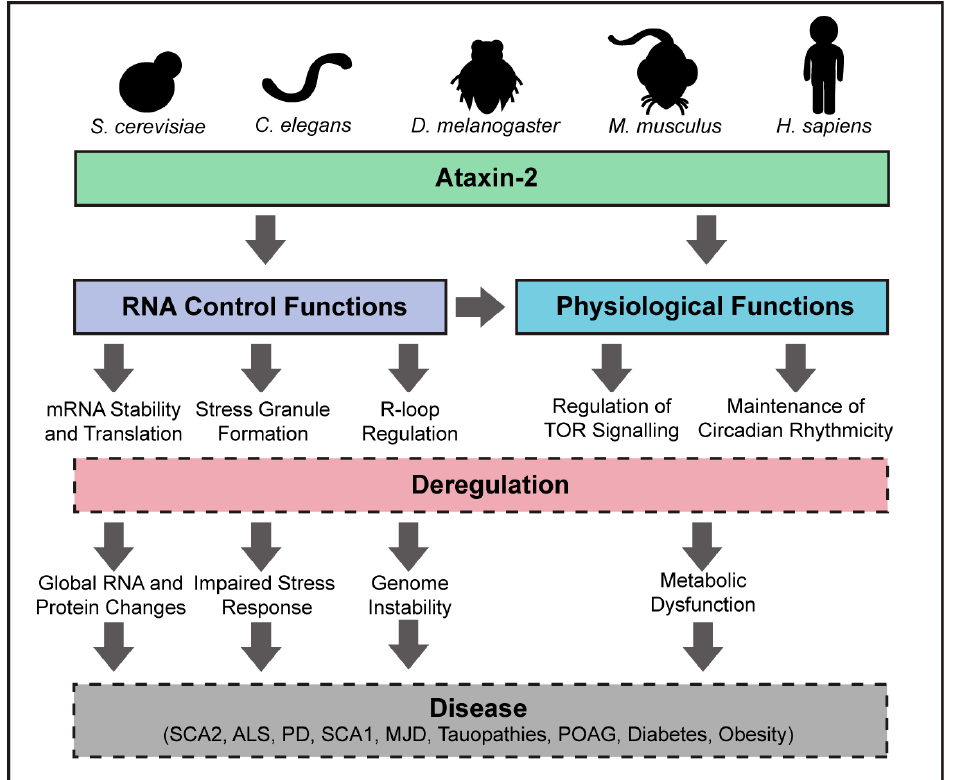
Figure 3. Multifaceted functions of Ataxin-2 and links to disease. Ataxin-2 functions to regulate several stages of RNA processing, with roles in physiological pathways. These functions include promoting mRNA stability and translation, as well as the regulation of R-loop and stress granule formation. These functions contribute to the control of metabolic pathways such as TOR and circadian rhythmicity. Deregulation of any of these processes can give rise to a wide range of cellular dysfunction, which can promote disease. SCA2, spinocerebellar ataxia type II; ALS, amyotrophic lateral sclerosis; PD, Parkinson’s disease; SCA1, spinocerebellar ataxia type I; MJD, Machado-Joseph’s disease; POAG, primary open angle glaucoma.